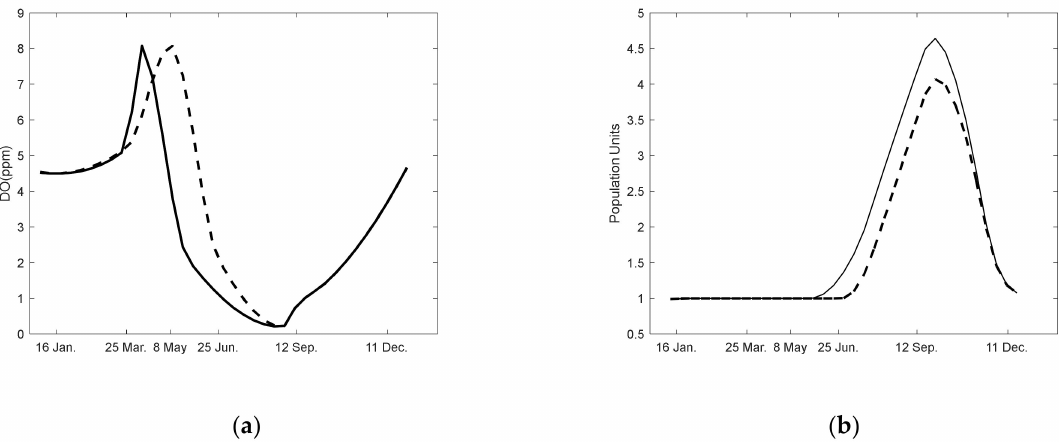
Figure 4. ( a ) Modified dissolved oxygen (DO) distribution to simulate hypoxia occurring one month earlier and for longer (solid line). ( b ) The population of Aurelia coerulea polyps for two cases of annual DO distributions. The solid line represents the simulated polyp population. If the hypoxia occurs earlier and lasts longer the population starts to grow earlier and becomes